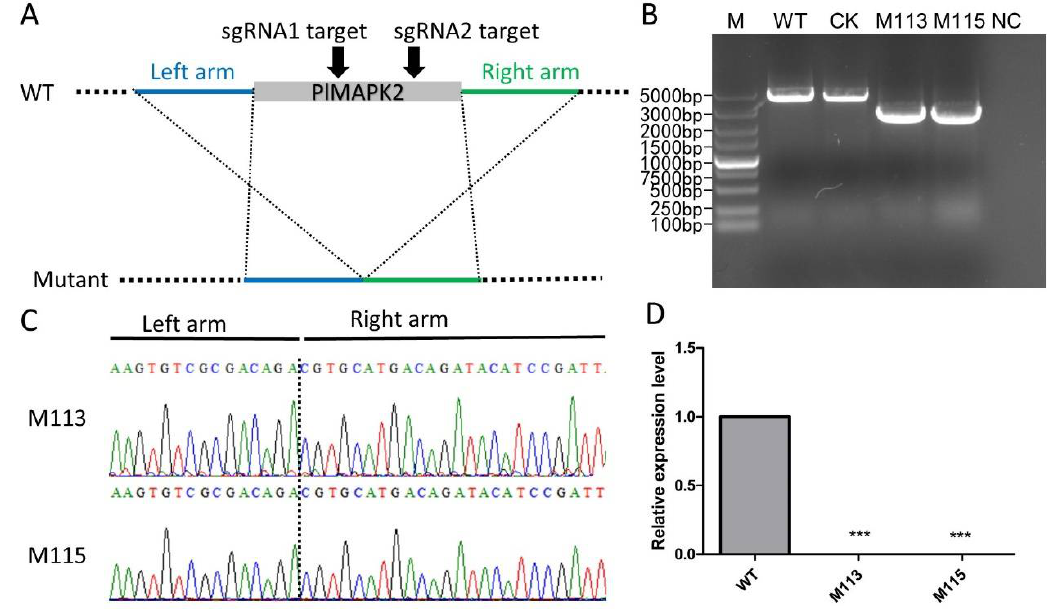
Figure 2. CRISPR/Cas9-mediated deletion of PlMAPK2 in P. litchii . ( A ) Schematic representation of the strategy of CRISPR/Cas9-mediated mutagenesis of PlMAPK2 . Two single-guide RNAs targeted the PlMAPK2 gene sequence (indicated by black arrows). The PlMAPK2 mutants were identified by genomic PCR ( B ) and sequencing ( C ). ( D ) PlMAPK2 was not expressed in PlMAPK2 mutants. WT: wild type; CK: the transformant failed to acquire PIMAPK2 mutation; NC: negative control (distilled water as template). “***” indicates significant difference ( t- test, p < 0.001). This experiment was repeated three times.